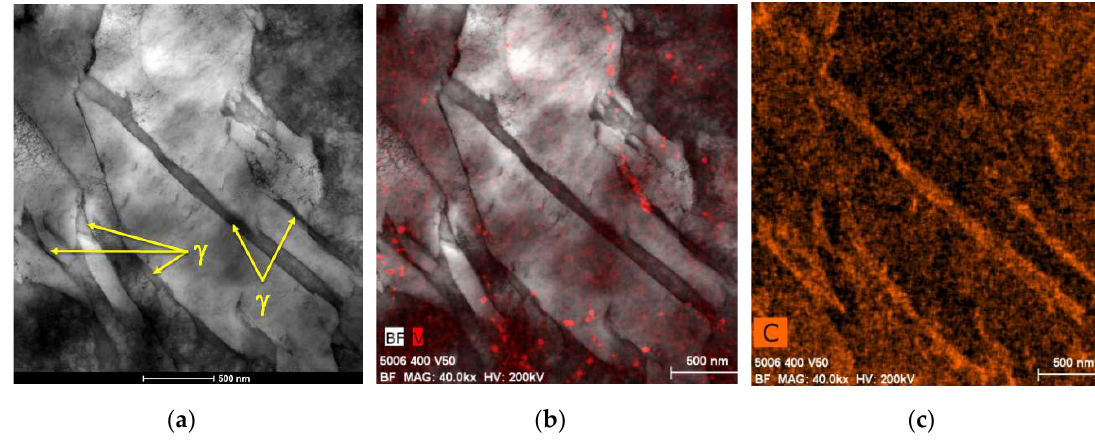
Figure 8. ( a ) Bright field STEM image of Ref+V transformed at 400 °C; ( b ) same as Figure 8a with a superimposed energy dispersive X-ray analysis (EDX) vanadium map (red) and ( c ) EDX carbon map (qualitative) from the same area.